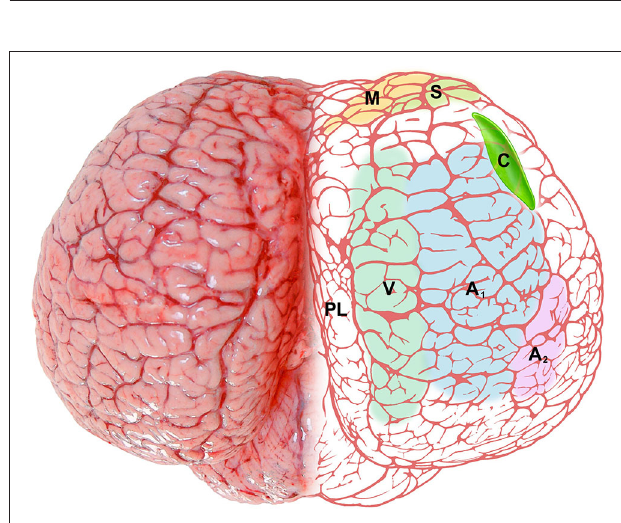
FIGURE 6 | Schematic representation of the claustrum (C, bright green) of the bottlenose dolphin shown through the dorsal aspect of the brain . The pale colors on the right side represent functional areas of the cortex: M (yellow), motor cortex; S (green), somatosensory cortex; V (gray-green), visual cortex; A 1 (pale blue), primary auditory cortex; A 2 (pale pink), secondary auditory cortex; PL (no color), paralimbic